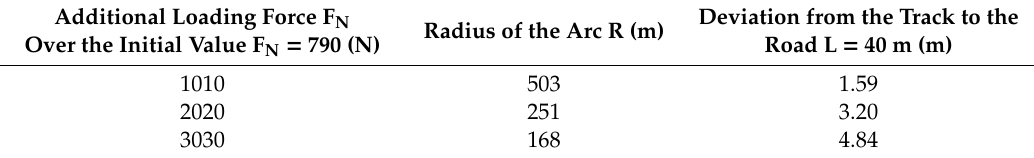
Table 3. Radii of curvature and deviation from the